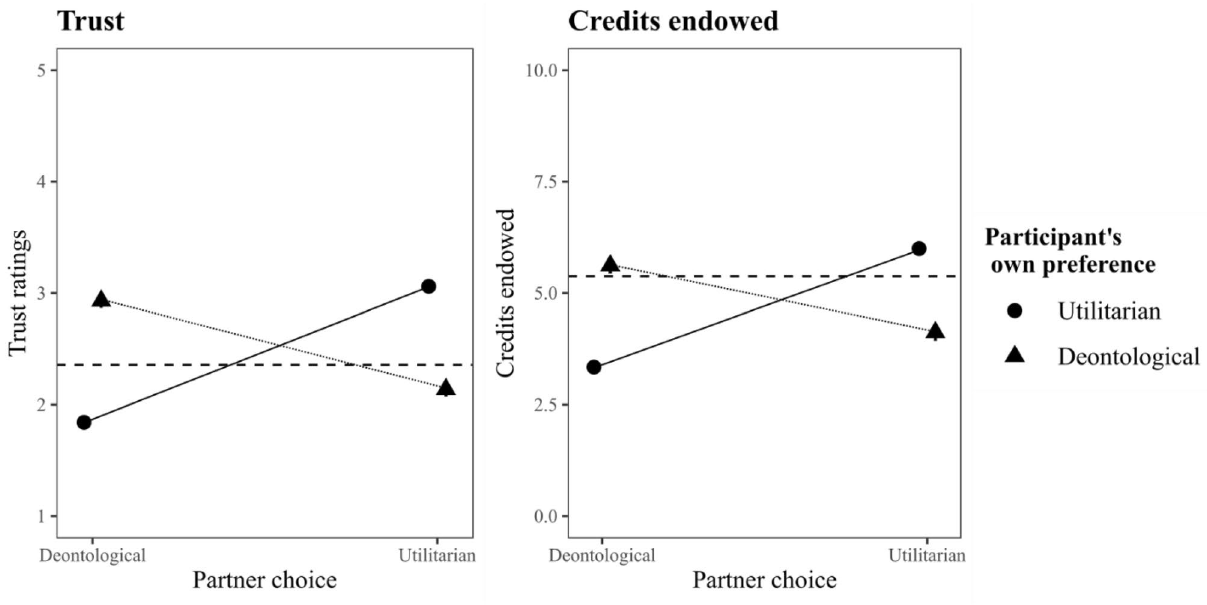
Figure 2. Inferred trust and cooperation in the main study as a function of partner judgment and participants’ own moral preference. Horizontal line designates average trust in or credits endowed to an unknown partner. Note. 95% Confidence intervals have been drawn but are not easily visible due to their small